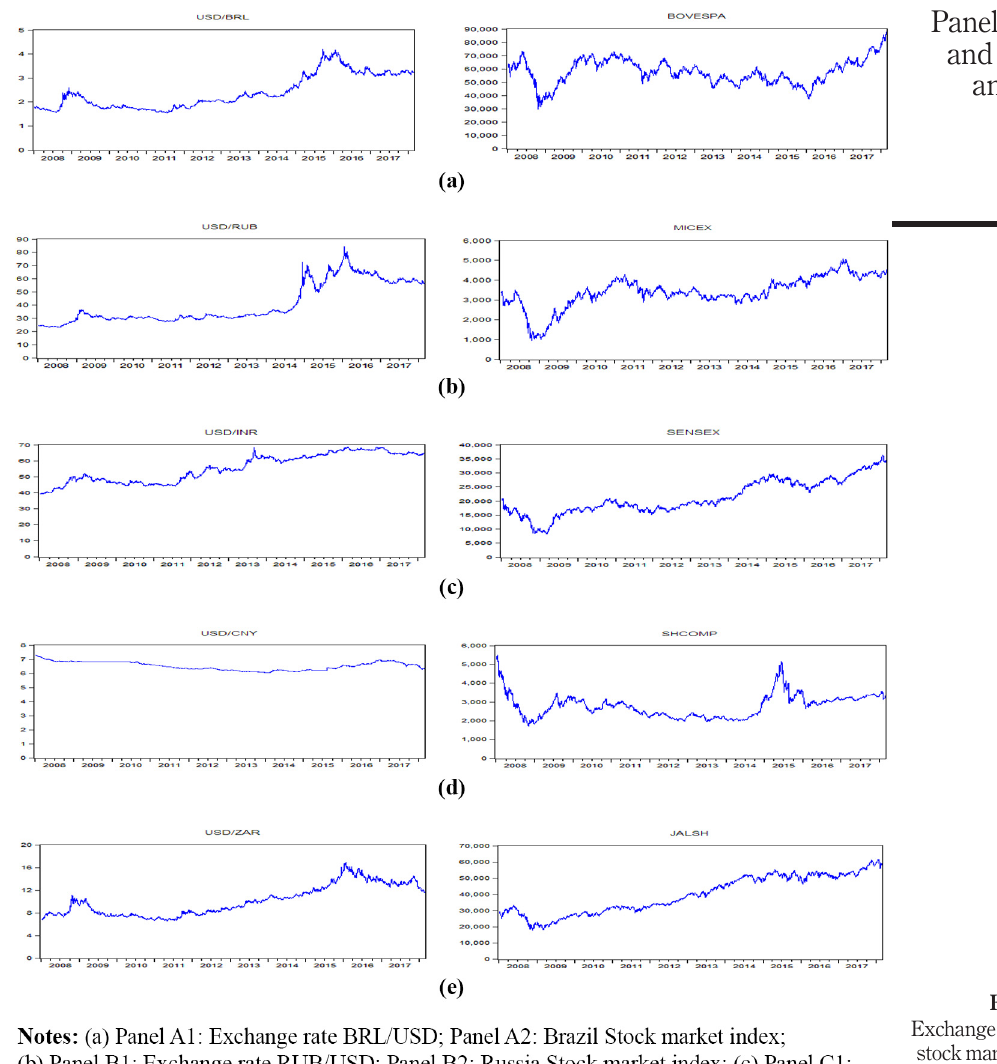
Figure 1. Exchange rates and stock market index prices trend on the BRICS countries (form January 1,